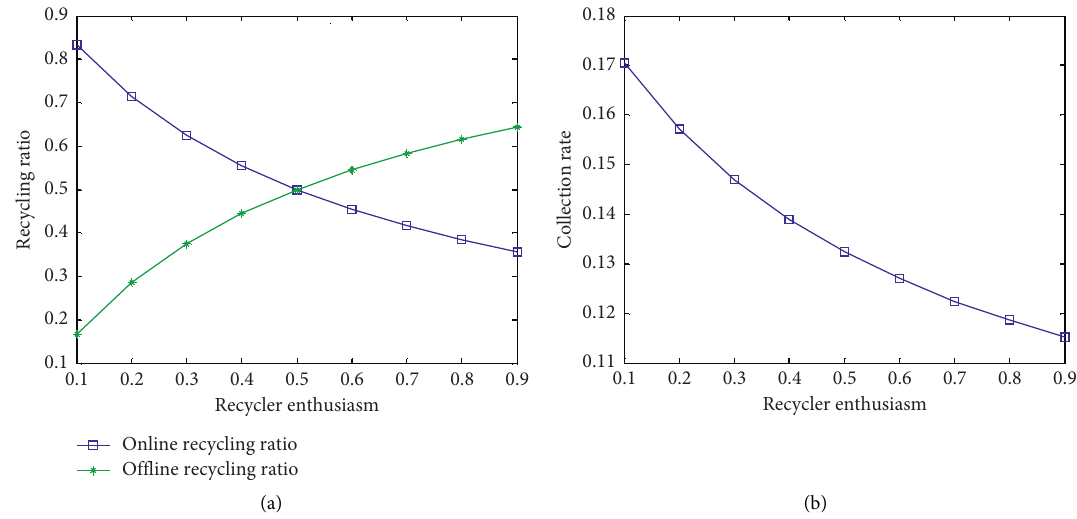
Figure 16: Offline recycling efficiency analysis chart. (a) Recycler enthusiasm and recycling ratio. (b) Recycler enthusiasm and collection rate.